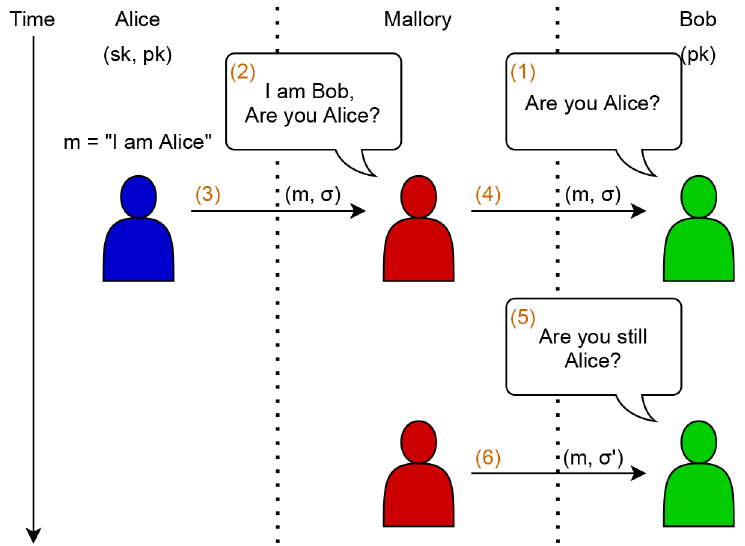
Figure 5. A simple problem on a digital signature schemes without